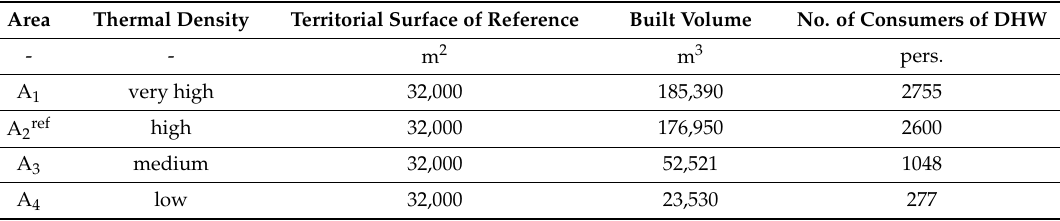
Table 2. Areas A 1 –A 4 and their characteristics [46].